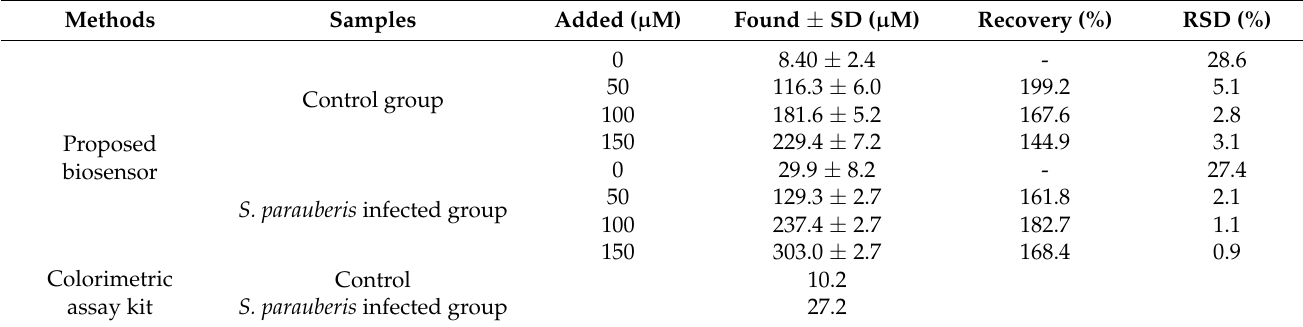
Table 3. Comparison of lactate concentrations measured in control and S. parauberis- infected fish spleen samples using the biosensor and the colorimetric assay kit.